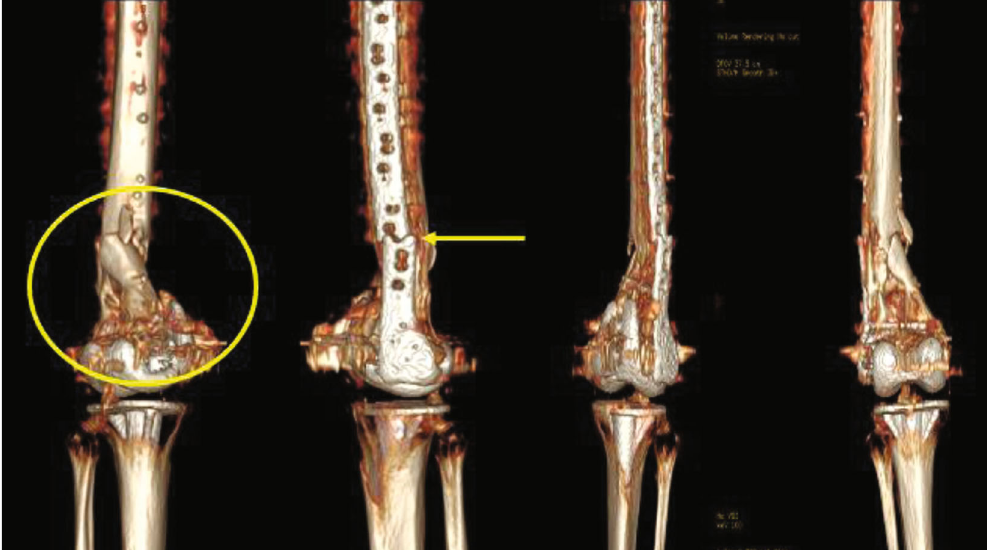
Figure 6: Postoperative follow-up with 3D reconstruction done one year postoperatively showing fracture nonunion (yellow circle), malalignment, and plate breakage (yellow